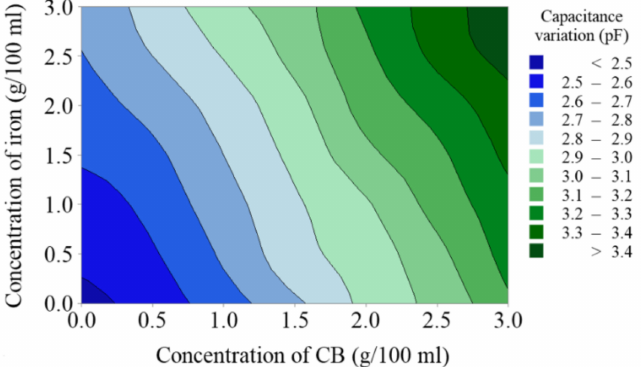
Figure 9. Contour of the measured capacitance increments versus the concentration of CB and Fe particles in EDM oil.